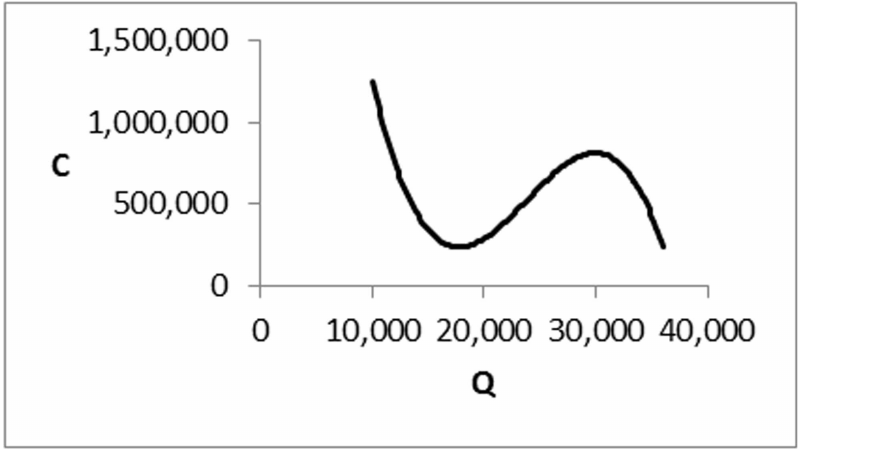
Fig 1. The cost of production ( C ) versus lot-size ( Q